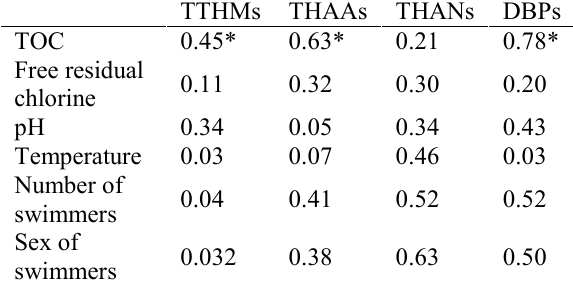
Table 4. The correlation coefficients between classes of DBPs and physicochemical parameters in the swimming pool water